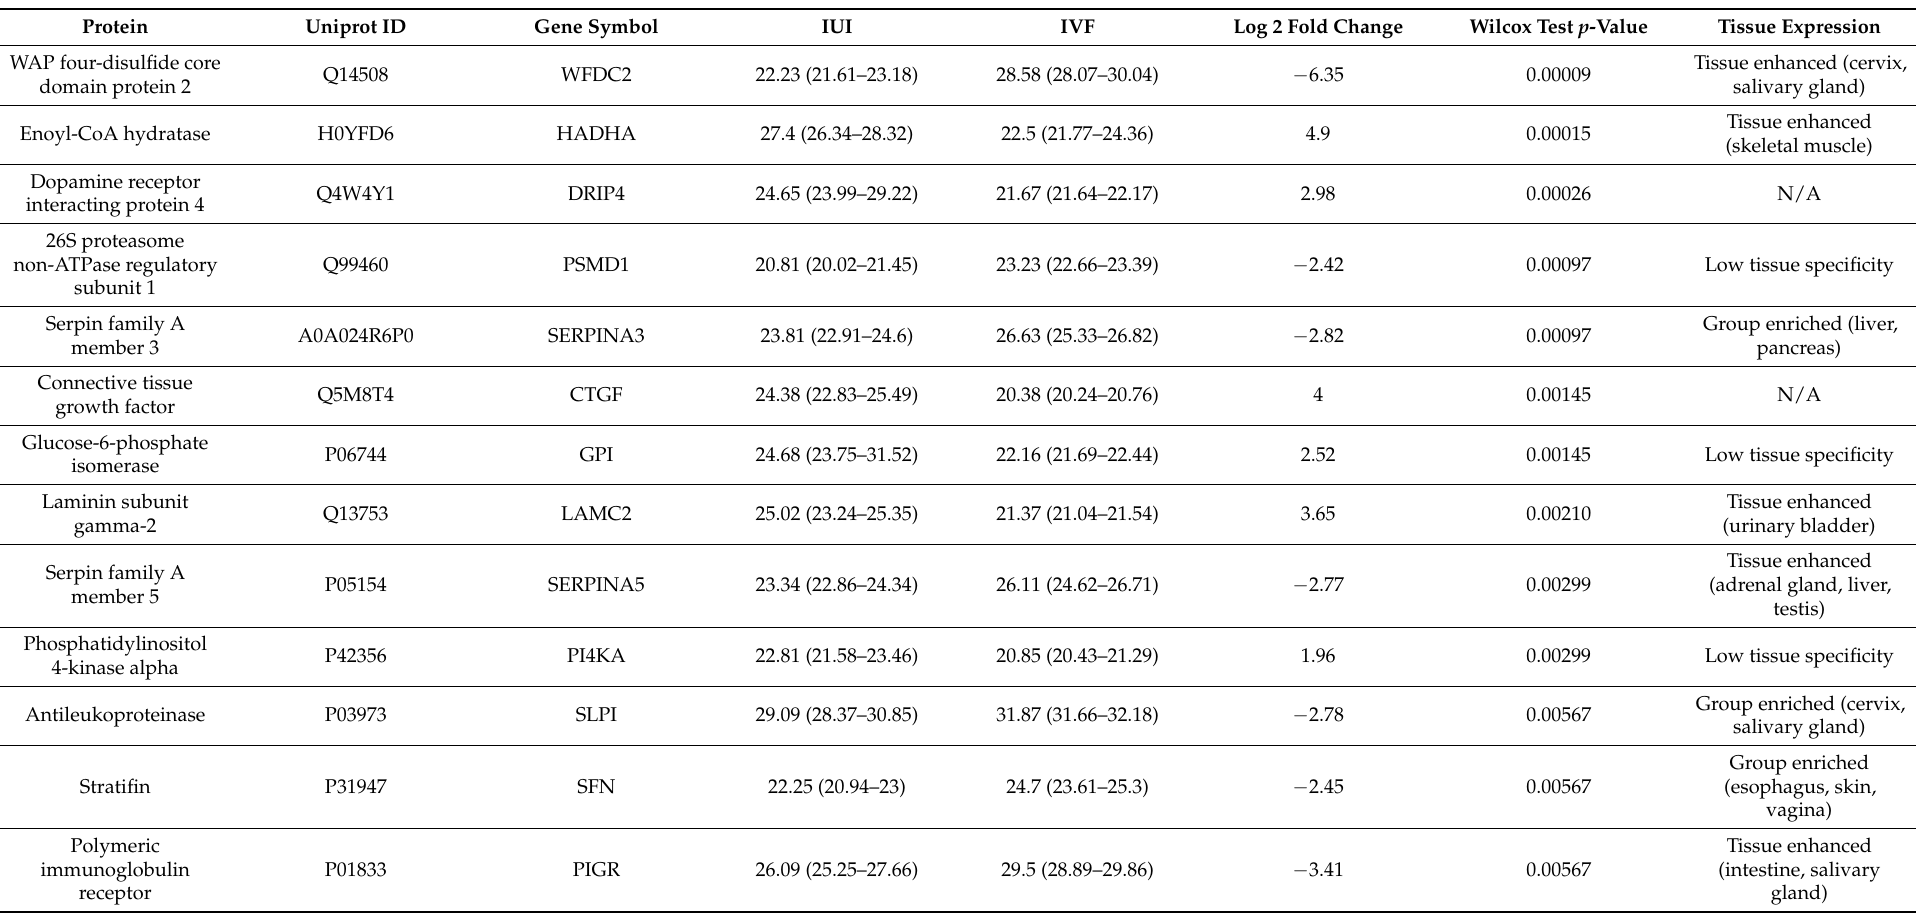
Table 2. The list of proteins distinguishing IUI from IVF cohorts. Those proteins were quantified in at least two replicates of all samples and have Wilcoxon test p values below 0.05. The protein intensities in the IUI and IVF columns are reported as medians with the minimum and maximum values of the log2-transformed aggregated intensity shown in parentheses. Log2 fold changes were calculated based on the median values and are reported as IUI/IVF ratios. Tissue expression data are from the Human protein atlas